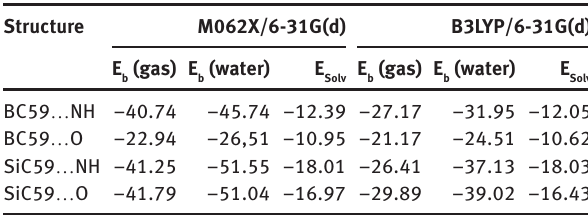
Table 1: Binding and solvent energies (kcal/mol) of the investigated